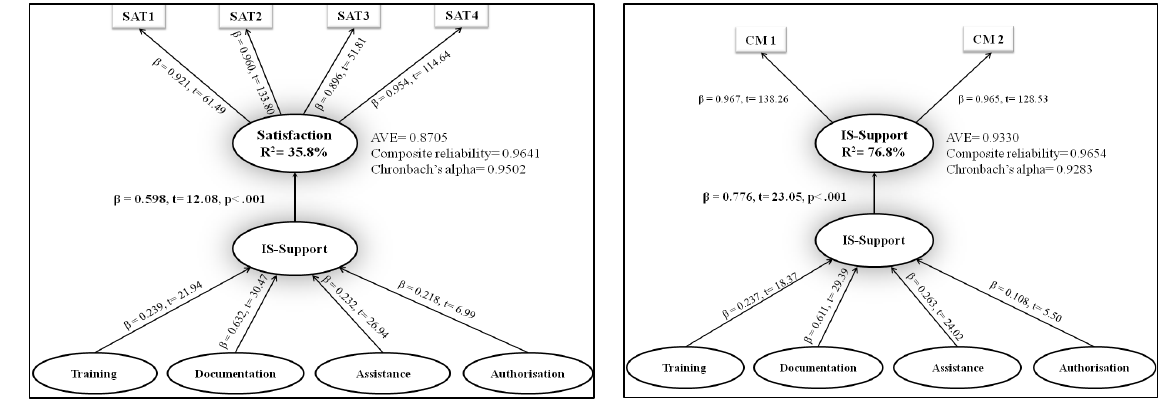
Fig. 3. Nomological validity of the IS-Support construct Fig. 4. External validity of the IS-Support